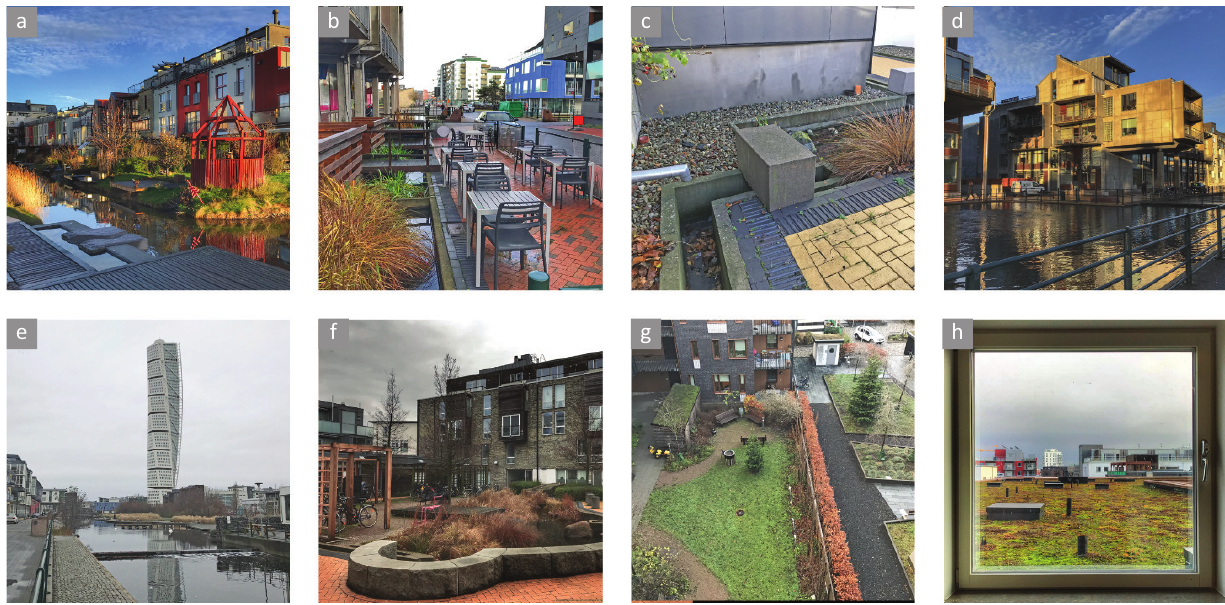
Figure 4. Bo01 precinct in Malmö: (a) Bo01 courtyard with water body; (b) and (c) Bo01 streetscape‐integrated elements for stormwater management; (d) and (e) Bo01 water bodies as a part of the urbanscape; (f) and (g) Bo01 courtyard gar‐ dens; (h) Bo01 green roof on a residential building.